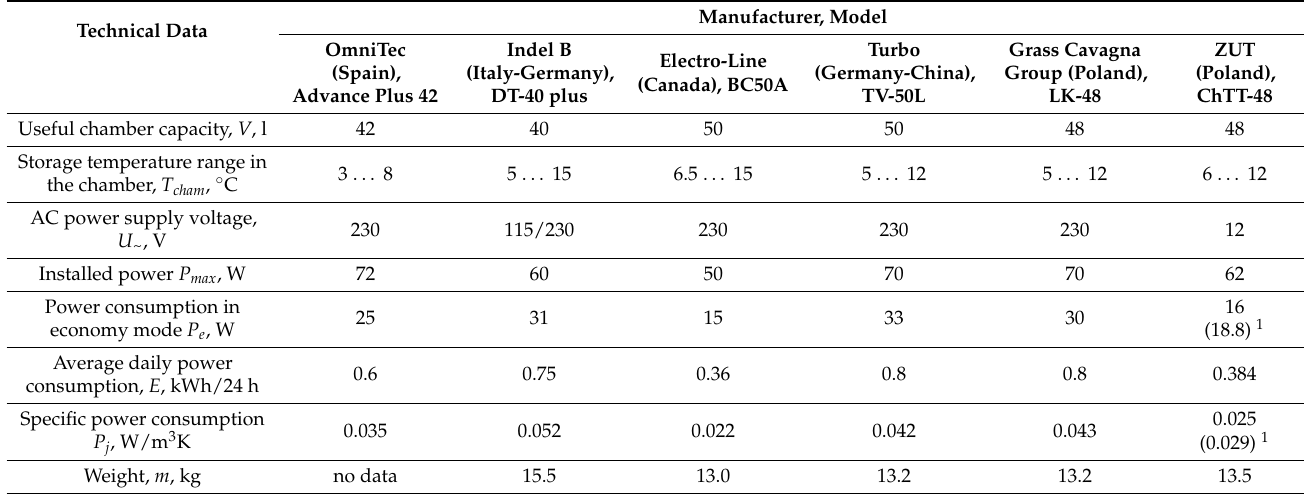
Table 1. Technical characteristics of modern stationary thermoelectric